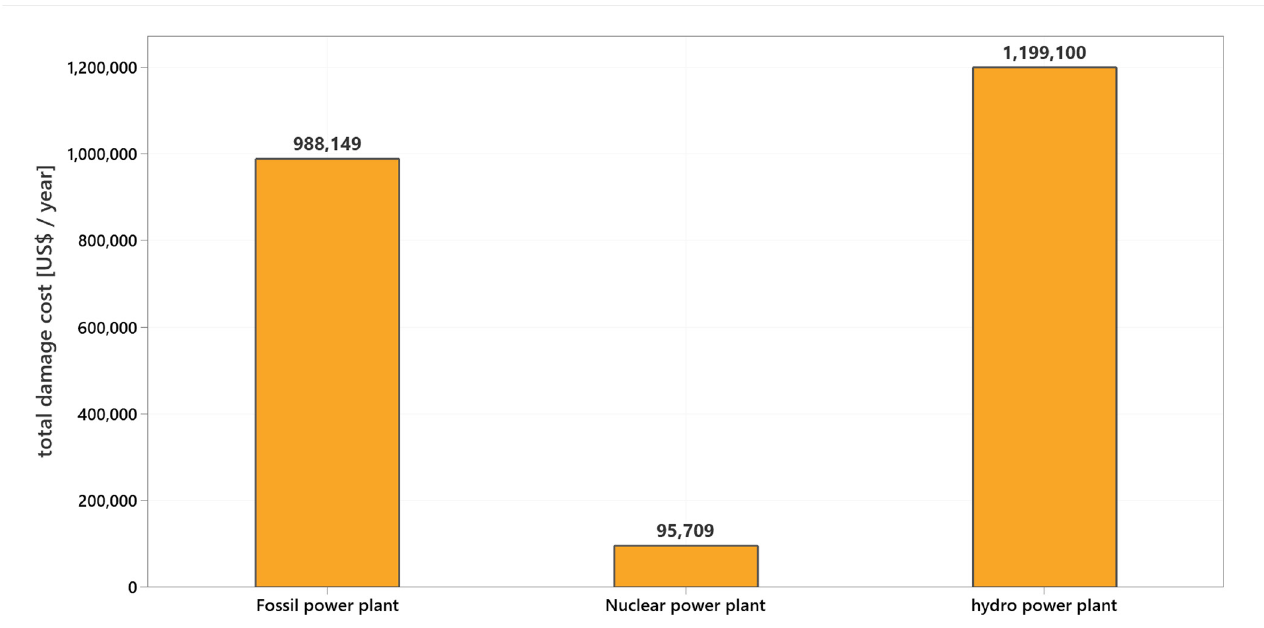
Figure 13. Total damage cost of electric power-plant